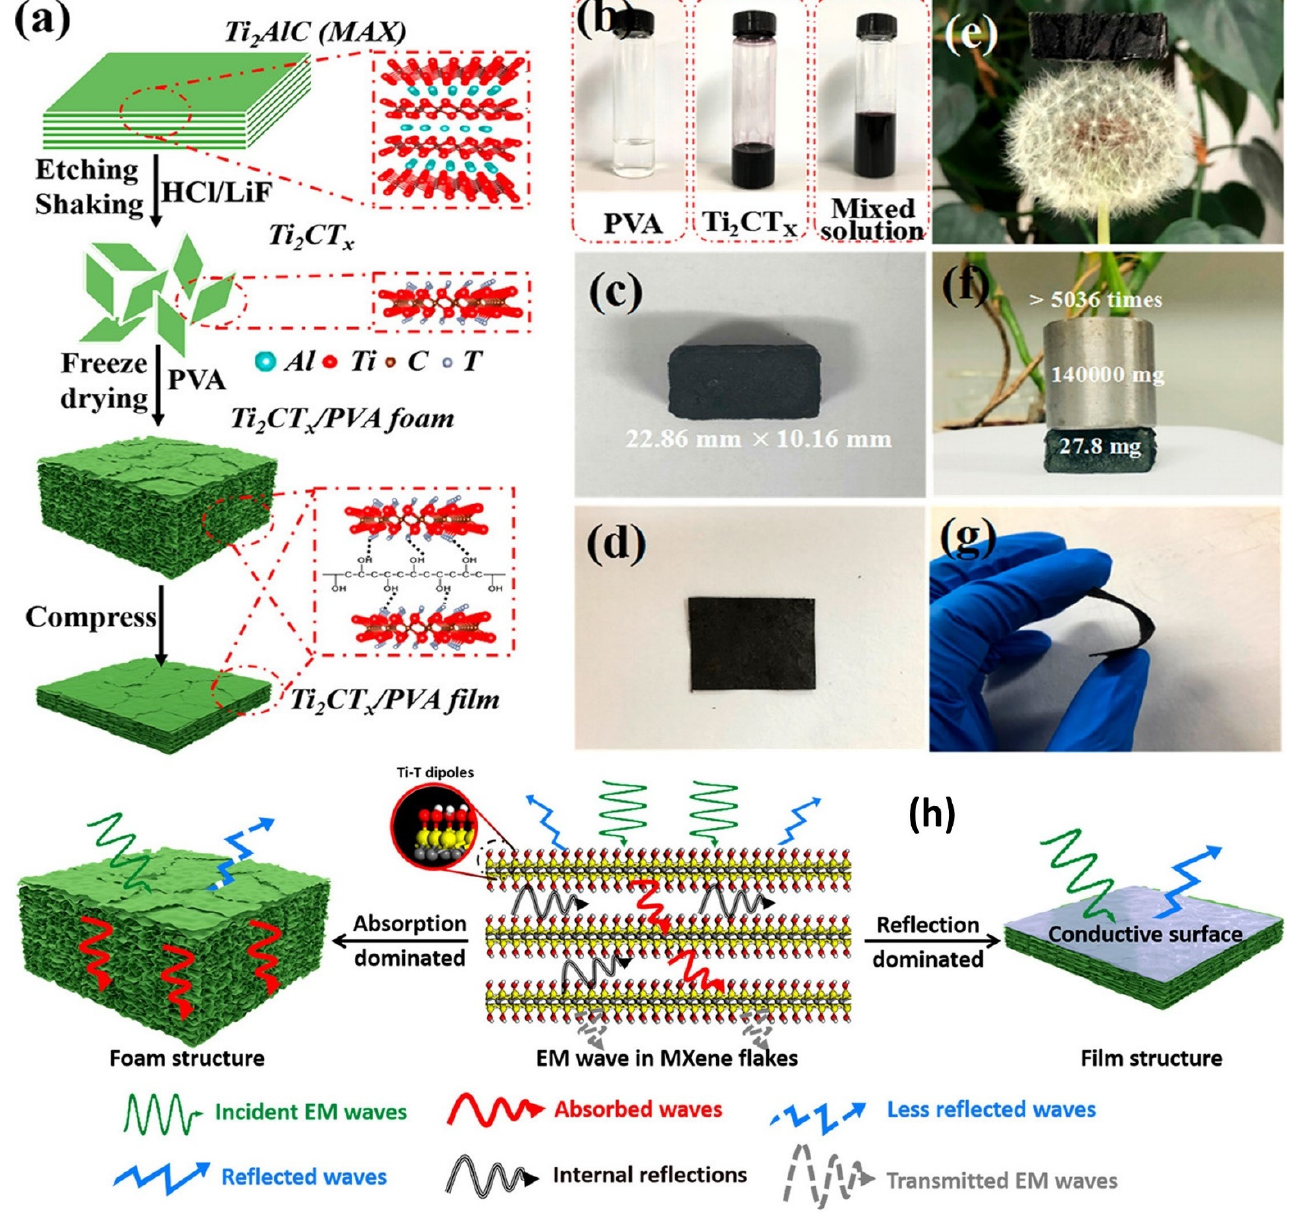
Figure 19. ( a ) Stepwise fabrication process of f-Ti 2 CT x /PVA composite film and foam. ( b ) Photographs of PVA solution (transparent), f-Ti 2 CT x solution (black color) and f-Ti 2 CT x /PVA solution. ( c , d ) Images of f-Ti 2 CT x /PVA foam and film. ( e ) Piece of this foam on a dandelion, depicting its ultra-low density. ( f ) Photograph of this foam supporting more than 5000 times its own weight. ( g ) Flexibility of f-Ti 2 CT x /PVA film. ( h ) Plausible EMI shielding mechanism of foam- and film-based MXene/PVA composites. Reproduced with permission from [163]. Copyright 2019, American Chemical Society.